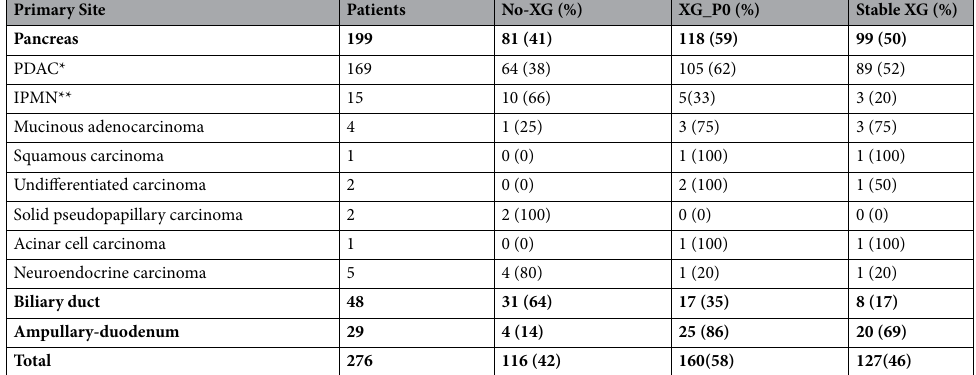
Table 1. Number of implanted specimens and engrafted xenograft tumor models. Patient-derived tumor models (XG) after initial passage (P0) in mice and serial passages for at least three passages to evaluate stable xenograft propagation (SXG). PDAC pancreatic ductal adenocarcinoma; IPMN intraductal papillary mucinous neoplasm. *A subset of PDAC were ascites specimens; 6/21 had initial engraftment and also formed SXG models. **15 IPMNs included eight with invasive adenocarcinoma; XG_P0 IMPN cases were associated with invasive adenocarcinoma (4/5) and one with focal invasion; Stable XG IPMN cases were associated with invasive adenocarcinoma (n = 2), and focal invasion (n =